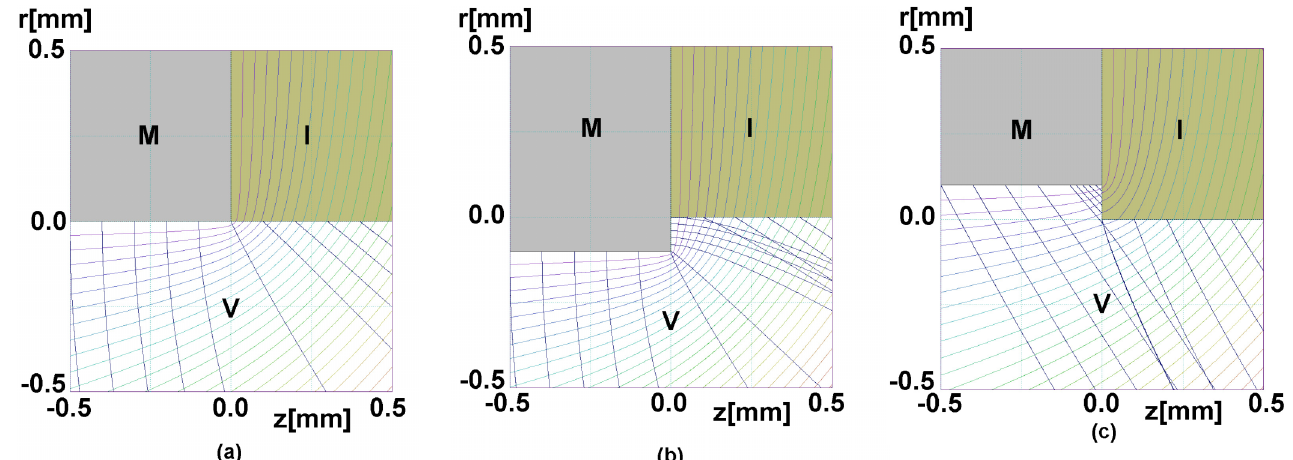
DIFFERENT APPROACH TO PULSED . .